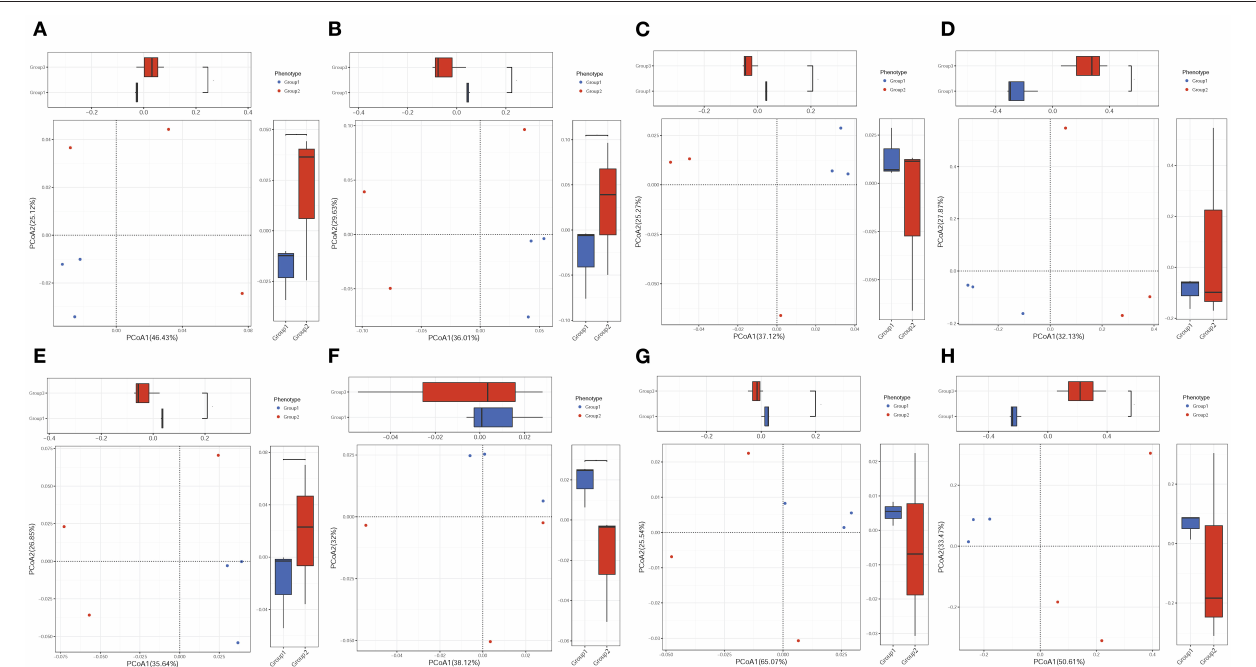
FIGURE 2 | PCoA of the effects of colistin on the pig gut microbiome composition. PCA of gut microbiome changes for ARDB (A) , eggNOG (B) , Enzyme (C) , Gene (D) , KO (E) , Module (F) , Pathway (G) , and Taxonomy (H) for different groups. Group 1, control group; group 2, the colistin group.